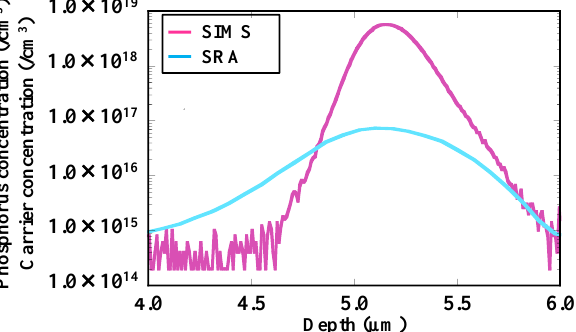
Figure 12. Superposition of depth profiles of phosphorus and carrier concentrations in CH 2 P- molecular-ion-implanted region after epitaxial growth.